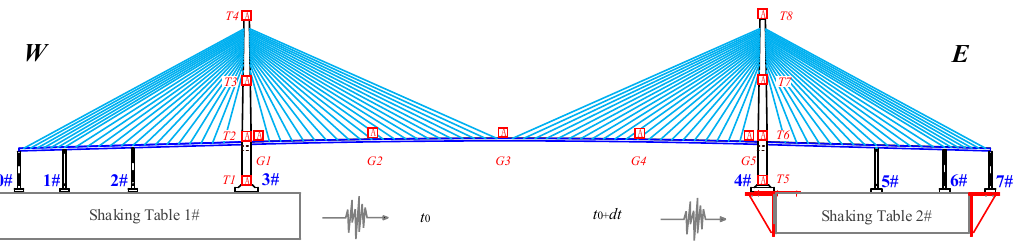
Figure 10. Schematic diagram of input excitations and sensors.